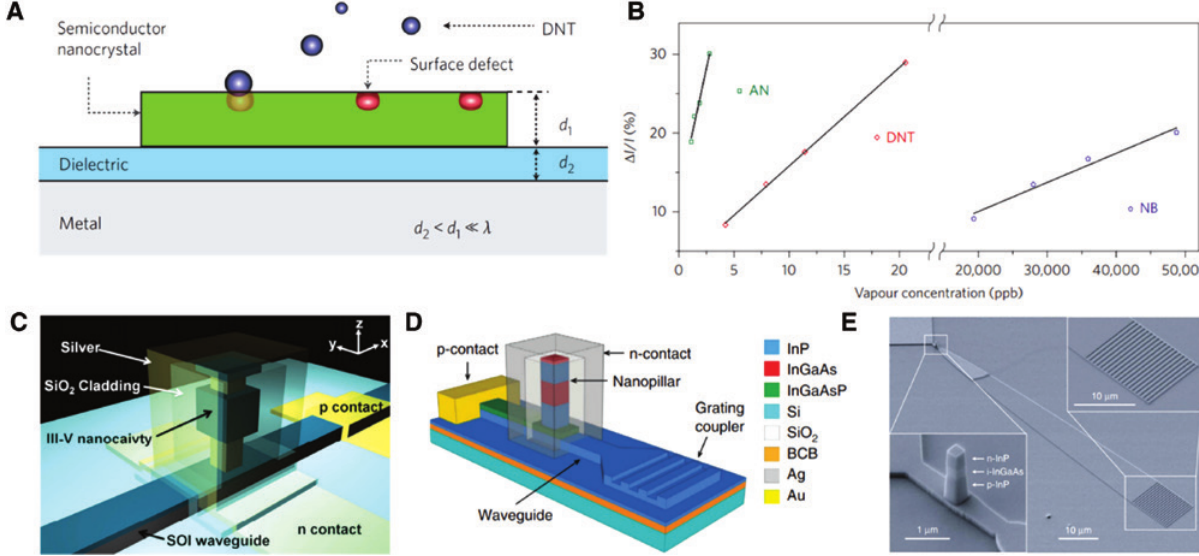
Figure 7: Applications of NW-like plasmonic waveguide. (A) Schematic of an active explosives nanosensor based on the lasing intensity change from a plasmonic nanocavity, where the semiconductor nanocrystal acts as both the gain medium and the sensing material. (B) Calibration curves for the 2,4-dinitrotoluene, ammonium nitrate, and nitrobenzene detected by the nanosensor in air; the sensitivities are defined as the slope of these calibration curves. Reproduced with permission [202]. Copyright 2014, Springer Nature. (C) Schematic of a metal-cladded plasmonic laser coupled with Si waveguide. Reproduced with permission [203]. Copyright 2011, The Optical Society. (D) Schematic of a nanopillar LED based on an n-InP/ InGaAs/p-InP nanopillar cladded by SiO /Ag on the silicon substrate. (E) Scanning electron microscope image of the nano-LED device before 2 metallization. Insets: enlarged view of the nanopillar and the grating coupler. Reproduced with permission [204]. Copyright 2017,